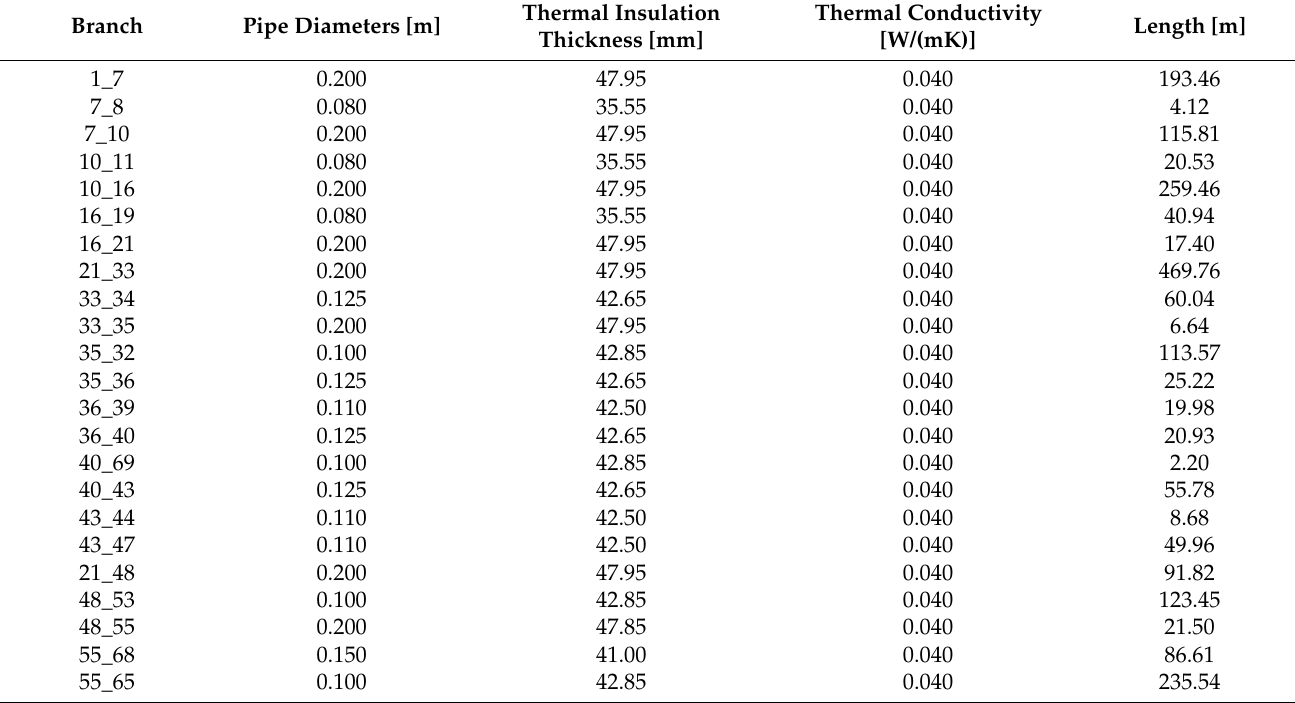
Table A2. Network technical